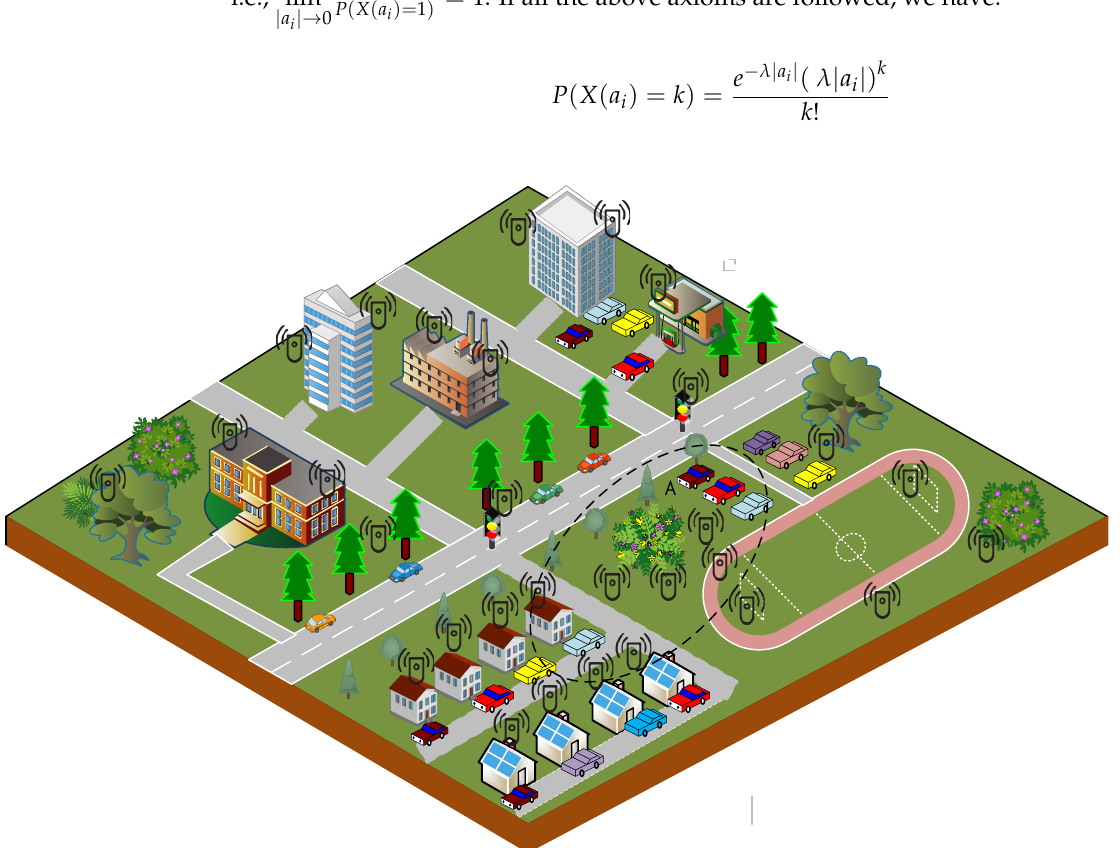
Figure 1. Smart campus environment with densely deployed sensors for round the clock information gathering and sur- veillance.